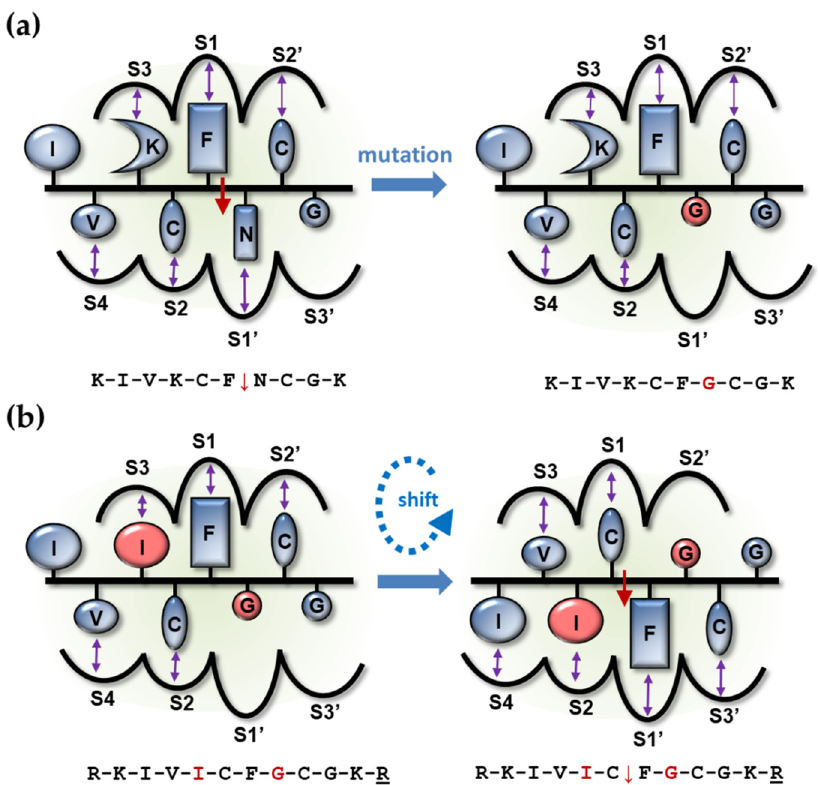
Figure 4. Predicted subsite interactions that lead to the shifted cleavage of the Ile for Lys-substituted peptide. Modified residues are highlighted in red. Favourable subsite interactions are indicated by purple arrows. The red arrow shows within the sequence if cleavage occurs. ( a ) The figure represents the productive binding mode of the peptide representing the naturally occurring proximal zinc-finger cleavage site in HIV-1 (peptide 1 in Table 3), leading to hydrolysis at the Phe ↓ Asn site. Upon P1 ′ Asn → Gly mutation, the peptide is not cleaved (peptide 14 in Table 3). ( b ) The peptide substrate is not processed by cleavage between Phe and Gly residues of the double-substituted peptide (peptide 16 in Table 3) when Ile occupies the S3 binding subsite. For this peptide, the same Ile residue occupies the S2 binding subsite in the productive binding where cleavage occurs between Cys and Phe residues.